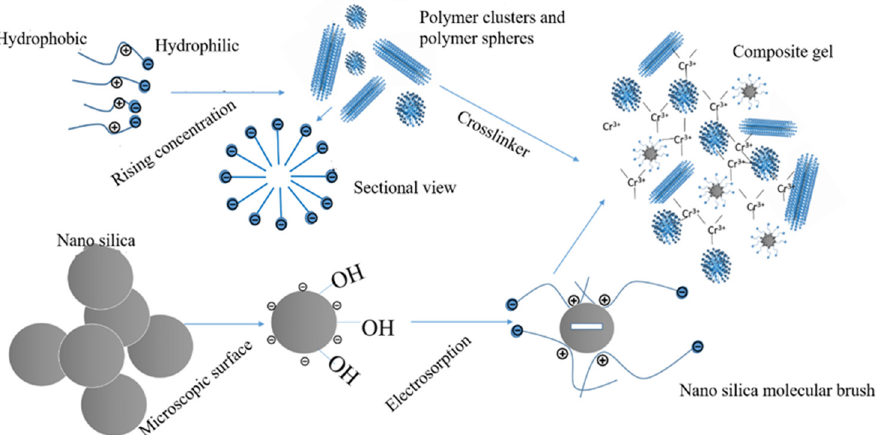
Figure 3. Mechanism diagram of organic chromium gel reinforced by nanosilica. (Reprinted/adapted with permission from Ref. [30], 2019, Yang et al.).